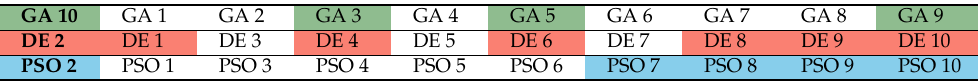
Table 6. Dunn–Sidak test results for GA 10, DE 2, and PSO